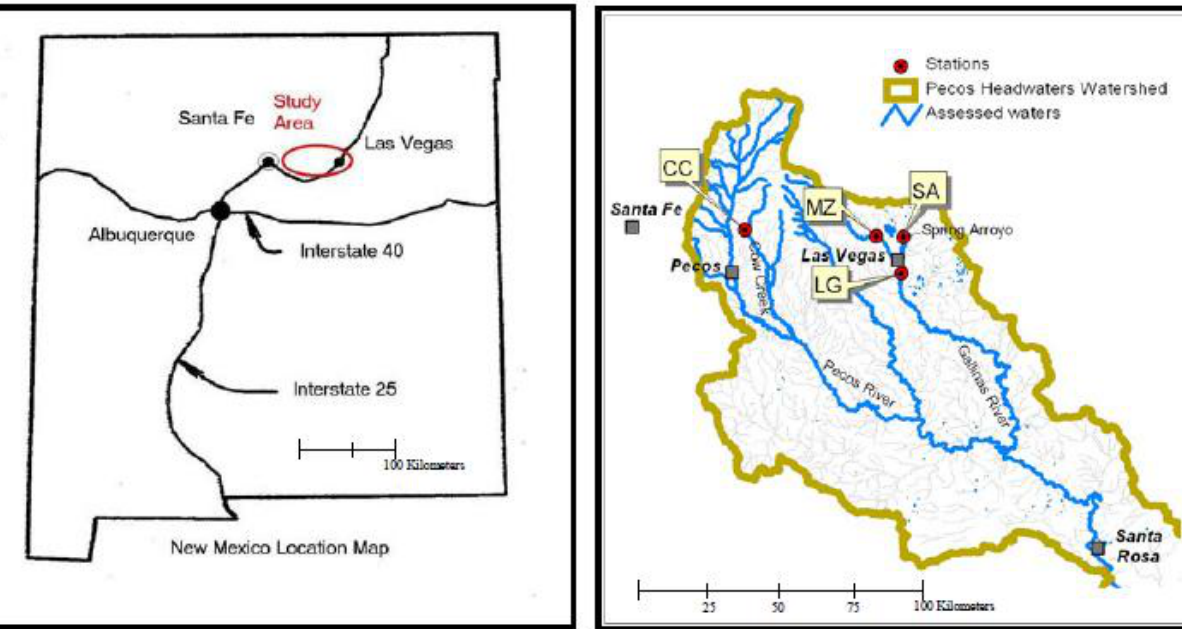
Figure 1. Upper Pecos River Basin with monitoring sites Upper Gallinas River